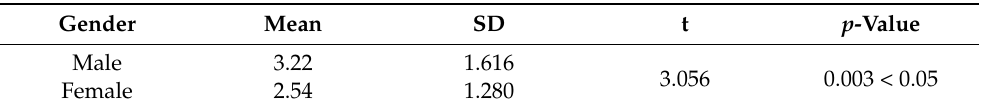
Table 4. Comparison of mean scores by gender.